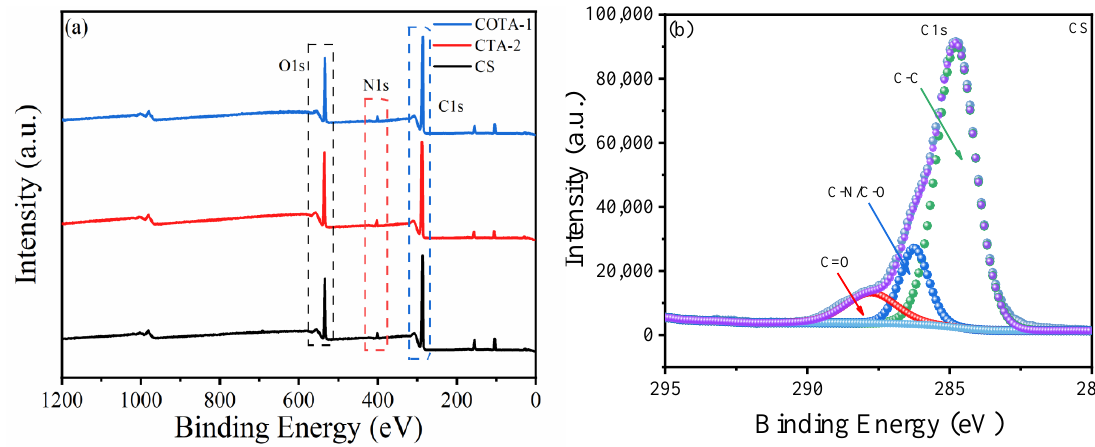
Figure 4. ( a ) XPS full-range spectra for the CS, CTA-2, and COTA-1 films; ( b ) C 1s region of the CS film; ( c ) C 1s region of the CTA-2 film; ( d ) C 1s region of the COTA-1 film.